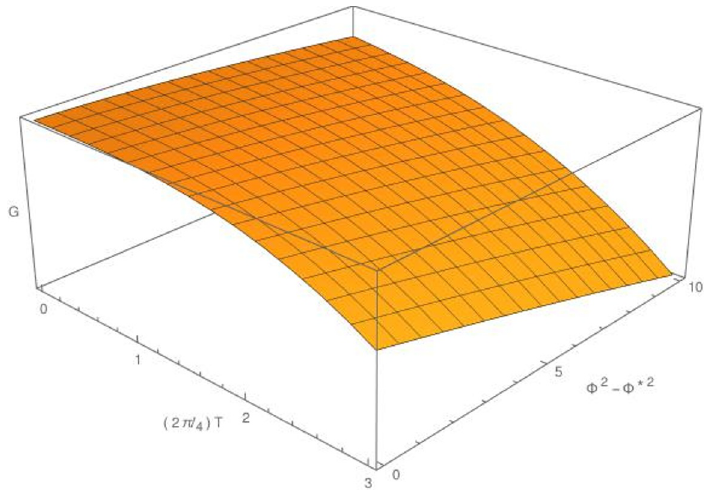
Figure 1 . Gibbs’ free energy G of the non-rotating AdS 4 black hole. The upper left corner is the BPS limit where Φ 2 − Φ 2 = T = 0 and G = 0 . The rest of the plot has positive potentials Φ 2 − Φ 2 ∗ and the free energy G < 0